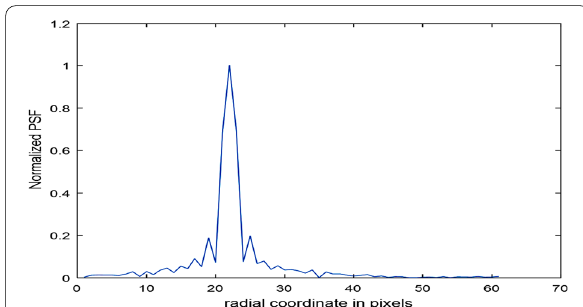
Fig. 8 Normalized PSF for the spiky aperture shown in the R.H.S. of (7). The radial coordinate range is from 236 up to 296 pixels of total range 60 pixels where the center is at 256 pixels. Hence, in the figure the peak is found at 22 pixels which deviate from the theoretical value by 2 pixels